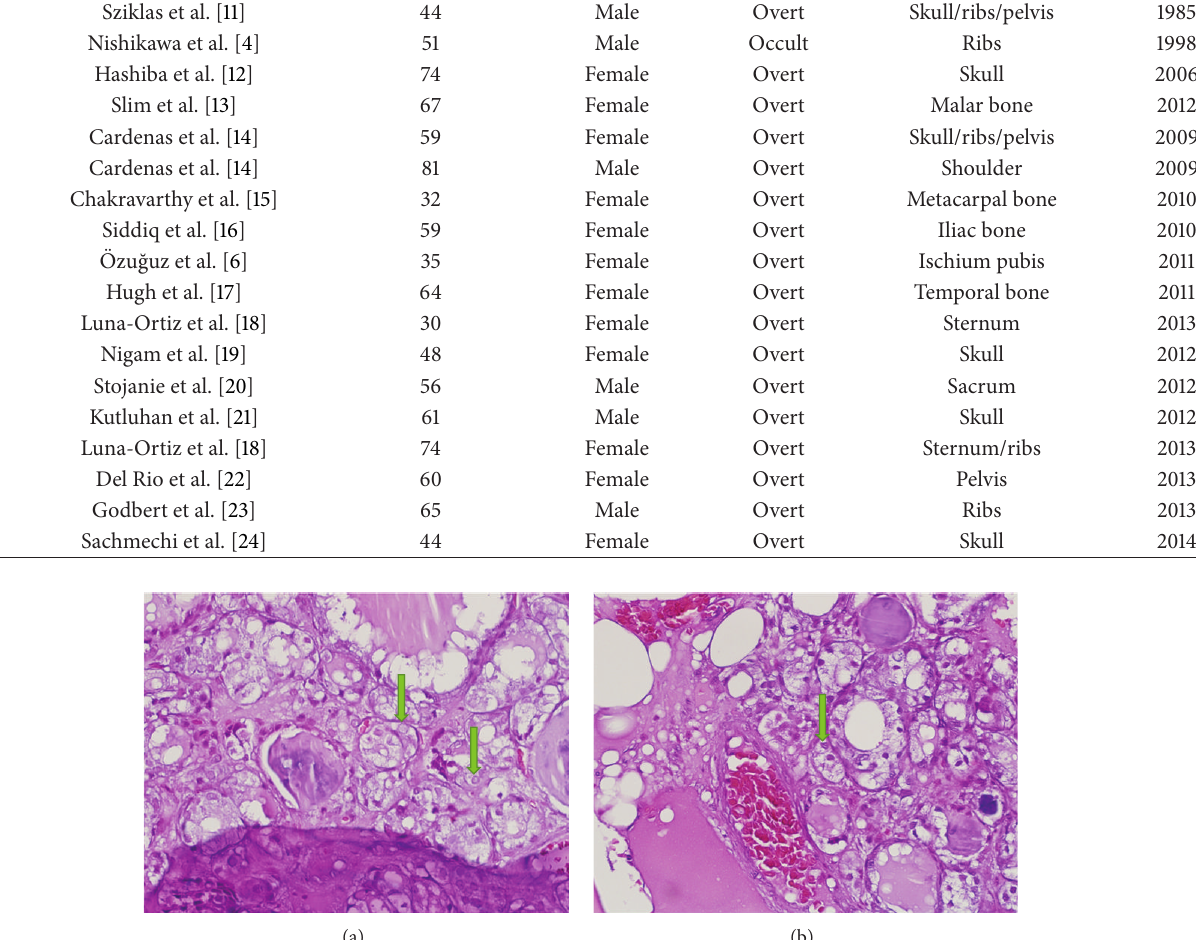
Figure 3: (a) HE × 20-nuclear overlapping is obvious in the lining tumor cells. (b) HE × 40-nuclear clearing in some nuclei